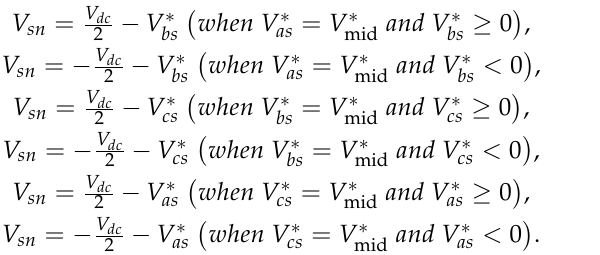
Figure 10. Voltage relations of other DPWM s : ( a ) + 30 ° DPWM; ( b ) 120° (on) DPWM; ( c ) 120° (off) DPWM. 4. Test Results of the IPMSM 4.1. Simulation Results The specifications of the IPMSM for the simulation are listed in Table 1. The simula- tion was conducted by configuring the block diagram shown in Figure 5. In the simula- tion, the back EMF of the IPMSM was assumed to be a sinusoidal wave, and the cogging torque was set to be 0. At this time, 10 kHz switching frequency was applied to all PWMs in simulations and experiments. The test simulated driving the motor at the desired speed